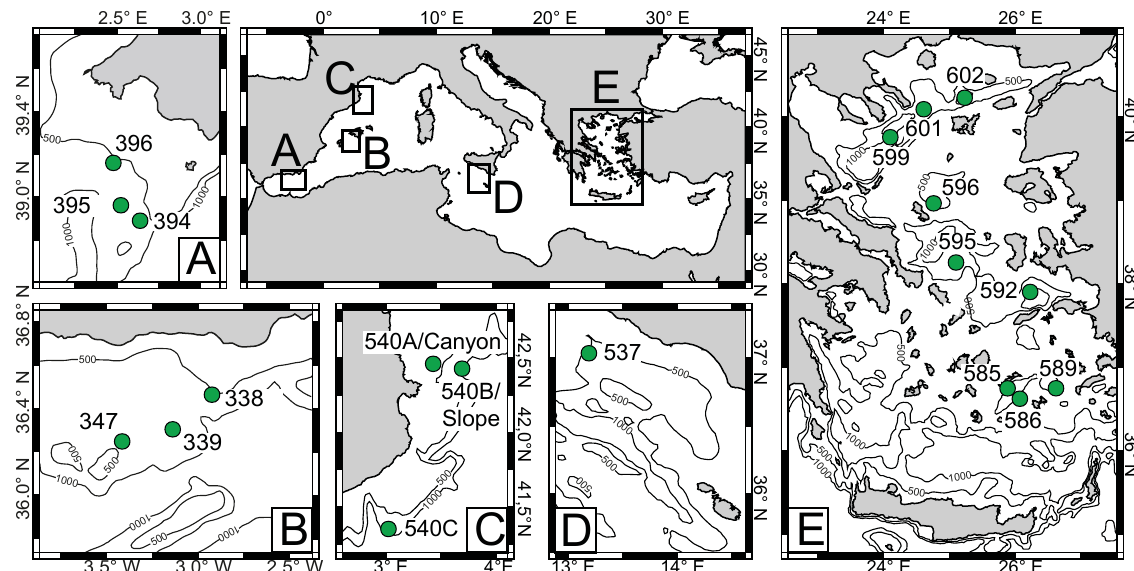
Figure 1. Location of the study areas in the Mediterranean Sea and regional bathymetric maps with locations of sample sites in the (a) Mal- lorca Channel, (b) Alboran Sea, (c) Gulf of Lion and Spanish slope off Barcelona, (d) Strait of Sicily, and (e) Aegean